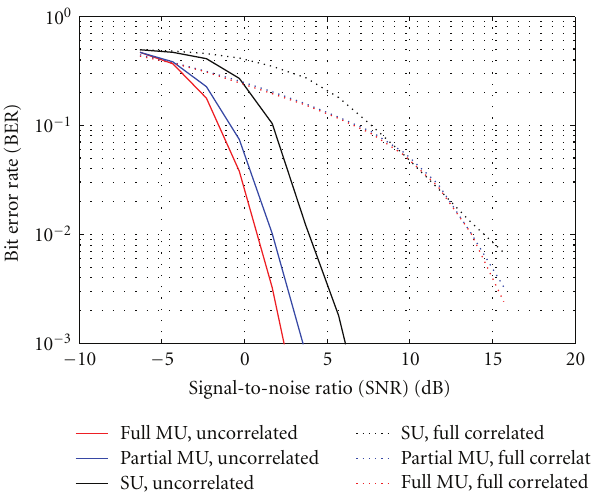
Figure 2: BER performance for DSA, for L = 2 in di ff erent types of feedback.